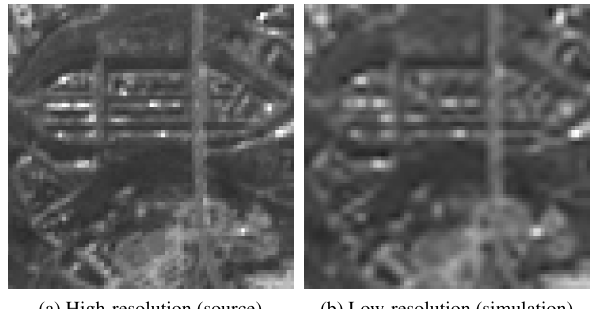
Figure 2: Low-resolution